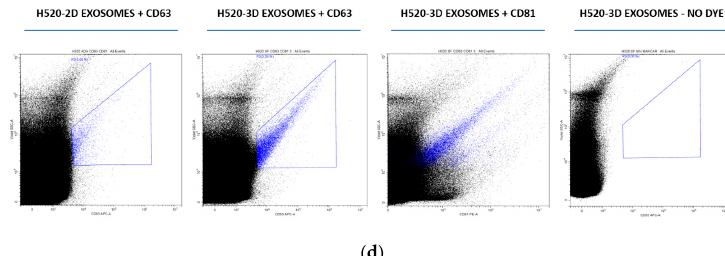
Figure 1. Characterization and quantification of isolated exosomes from tumor cell cultures. ( a ) Representation of the concentration and size distribution obtained using a NanoSight NS300 instrument after analysis of sample FIS 435-2D. Readings were taken five times over 60 s at 10 frames per second at room temperature. An average of all recordings was calculated and is represented in red (top panel). Average size (nm) and standard deviation (SD) were calculated for 2D and 3D exosome samples (bottom panel). ( b ) Representative transmission electron microscopic images of H520-derived exosomes (2D and 3D cell cultures) from NSCLC tumor cells. ( c ) Immunoblotting analysis for exosomal surface markers TSG101 and CD9. Calnexin was used as a negative control for exosome samples (using cell lines H1650 and SW900 as controls and FIS 471, 435 and 301 as primary cultures). β -Actin was used to assess equal protein loading. ( d ) Flow cytometry analysis of surface markers CD63 and CD81 in H520-derived exosomes isolated from 2D and 3D cell cultures.